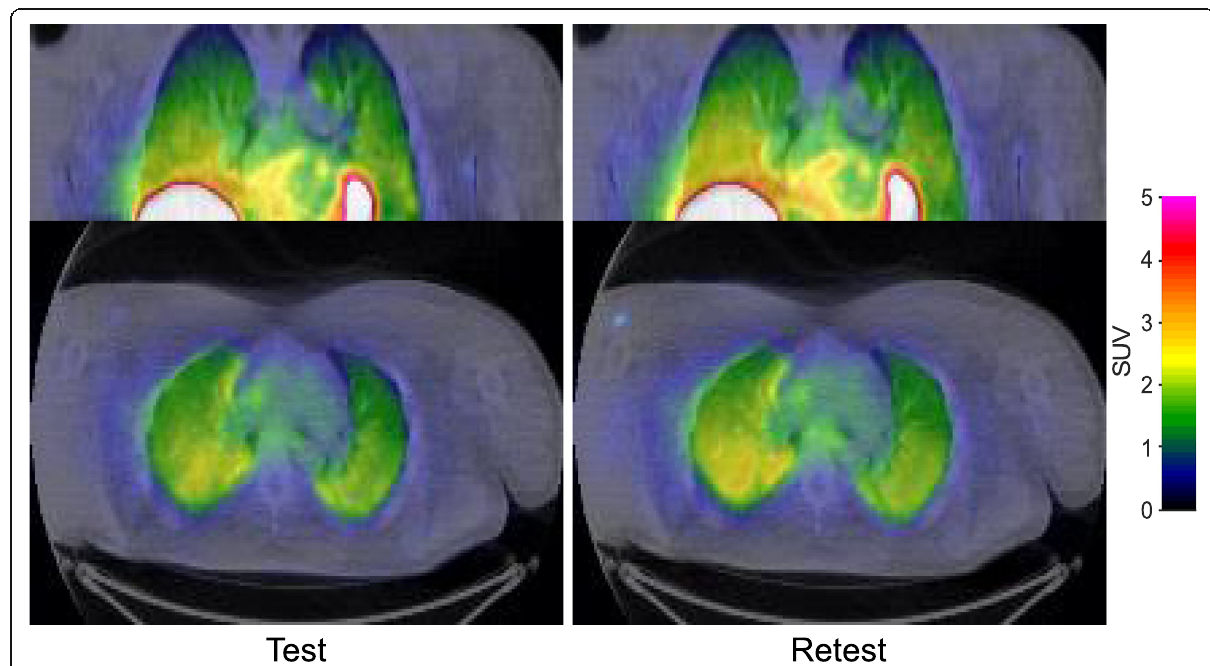
Fig. 1 Coronal and axial summation PET images (0 – 93 min) in thorax after intravenous injection of the radioligand [ 11 C]VC-002 in healthy subject #1. Coloured PET images in standardized uptake value units (SUV) are overlaid on structural CT images in grey